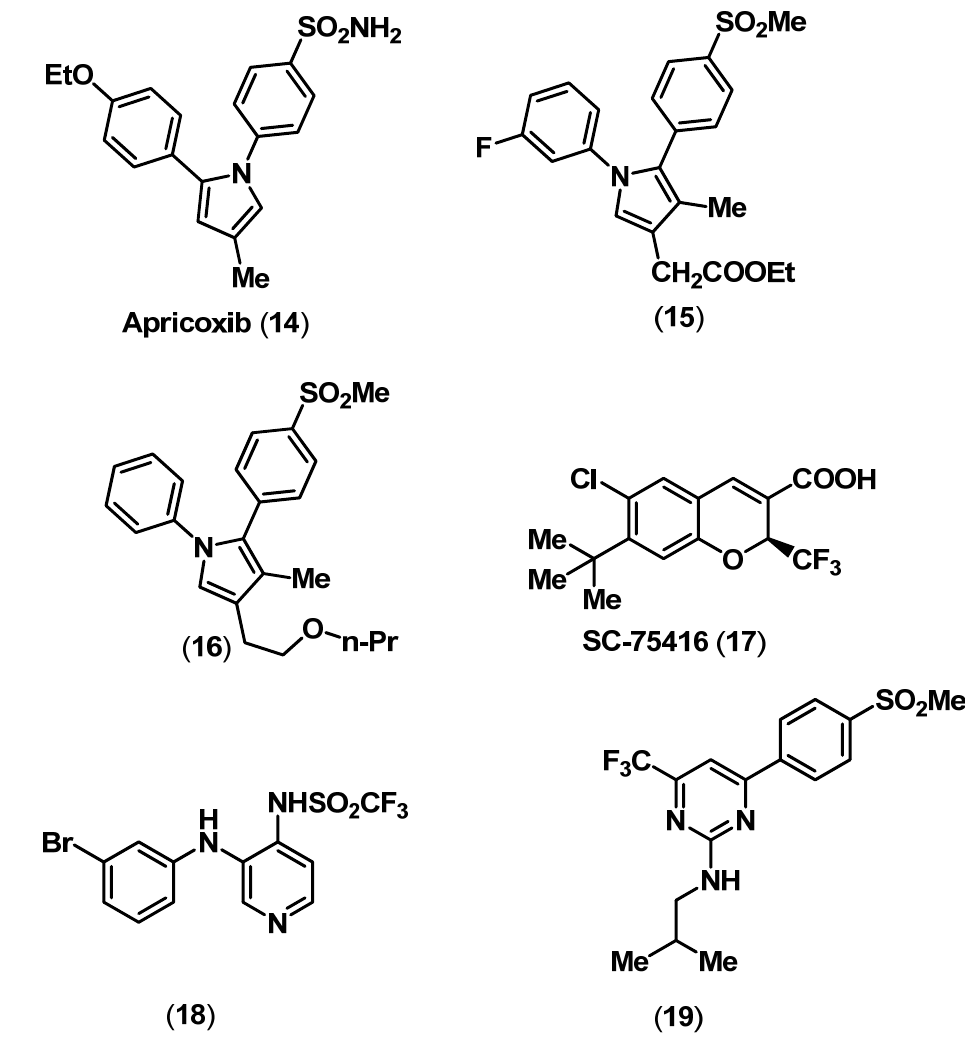
Figure 4. Chemical structures of some representative selective COX-2